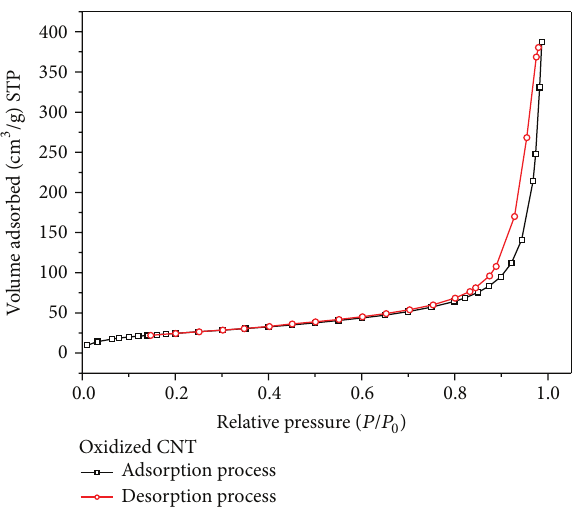
Figure 13: Adsorption-desorption isotherm of oxidized nanotubes.